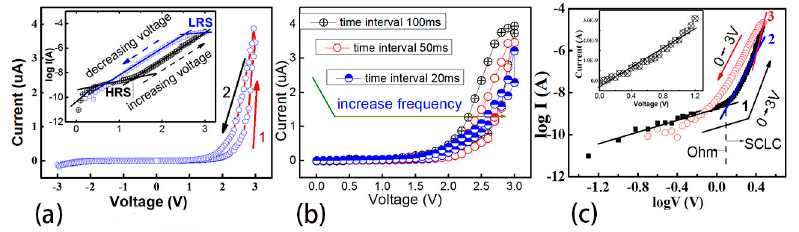
Figure 2. I–V characteristic curve ( a ) I–V curve at room temperature; ( b ) frequency-independent I–V curve; and ( c ) logI–logV characteristics curve.